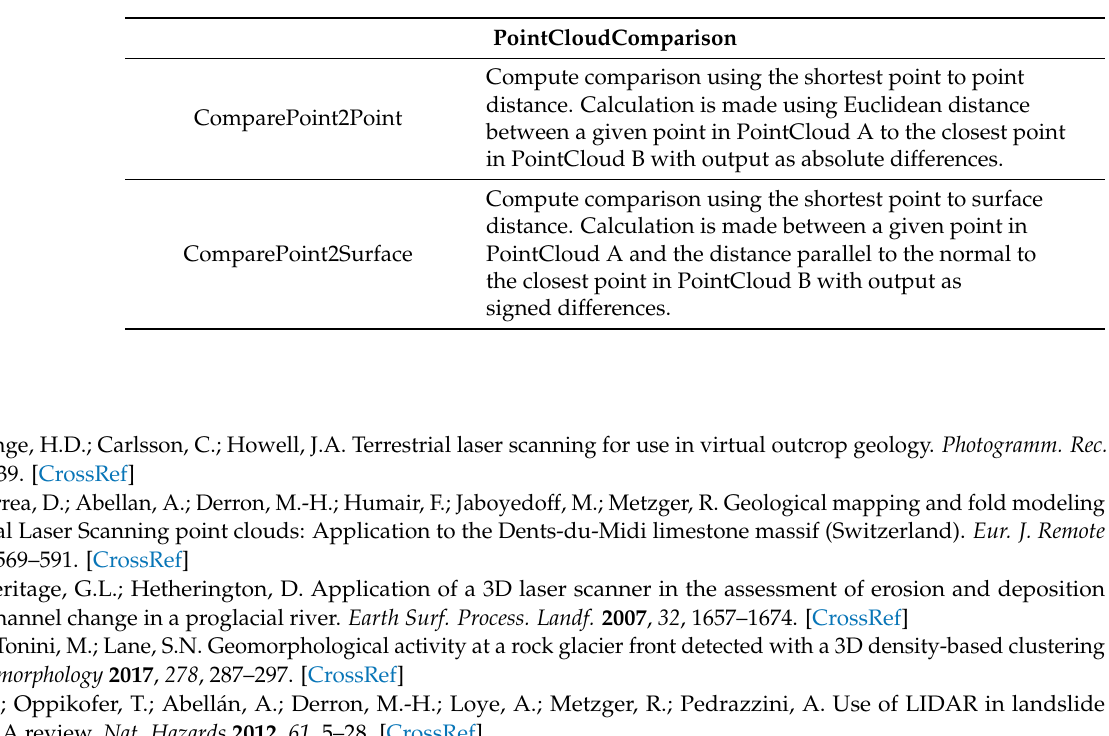
Table A5. Functions available in the PointCloudComparison